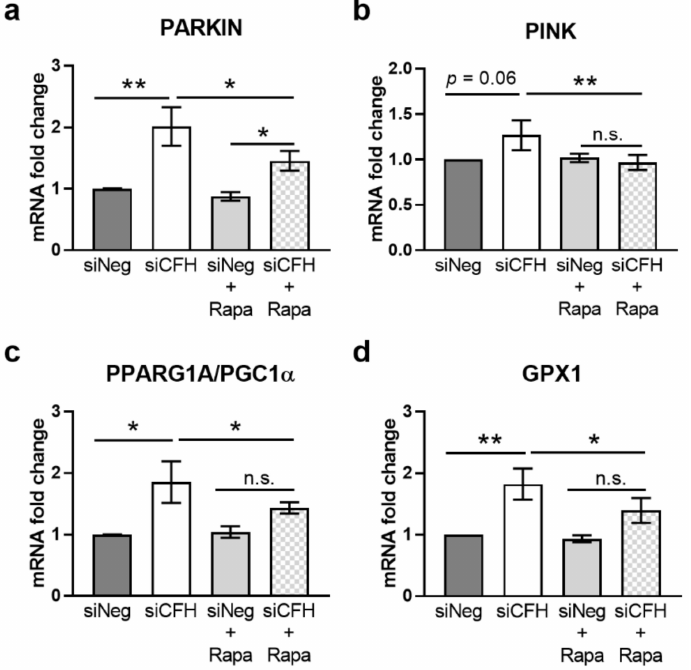
Figure 3. Rapamycin reverts FH knockdown-mediated effects on gene expression. hTERT-RPE1 cells were silenced for 24 h with negative control (siNeg) or CFH specific (siCFH) siRNA and then incubated in SFM containing 200 nM rapamycin or DMSO for 48 h. Cell pellets were collected for RNA extraction, cDNA synthesis, and qRT-PCR analyses. ( a ) Evaluation of gene expression levels of E3 Ubiquitin-Protein Ligase Parkin (PARKIN). ( b ) Evaluation of gene expression levels of PTEN induced putative kinase 1 (PINK1). ( c ) Evaluation of gene expression levels of Peroxisome Proliferator-Activated Receptor Gamma Coactivator 1-Alpha (PGC1 α ). ( d ) Evaluation of gene expression levels of Glutathione Peroxidase 1 (GPX1). Data are normalized to housekeeping gene RPLP0 using ∆∆ Ct method. SEM is shown, n = 8. Significance was assessed by Student’s t -test; * p < 0.05, ** p < 0.01. n.s. not